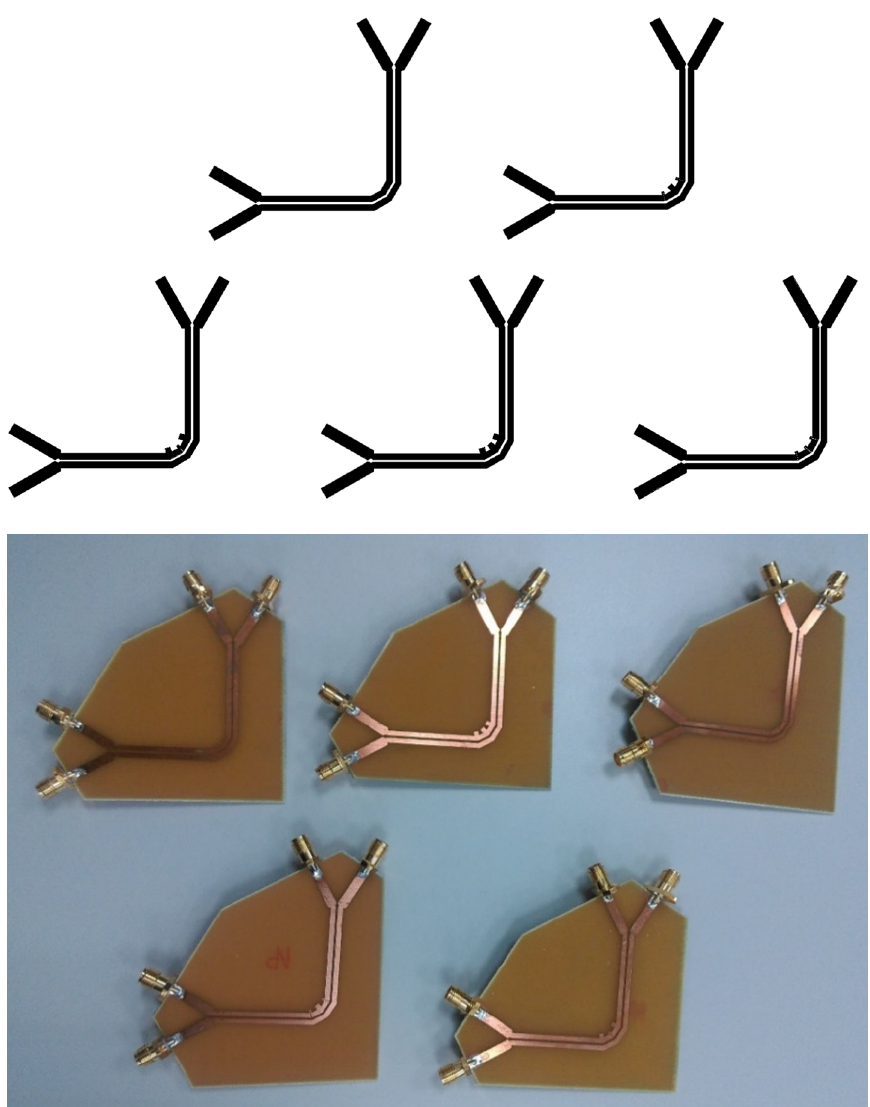
Figure 13. PCB layout geometry and photographs.